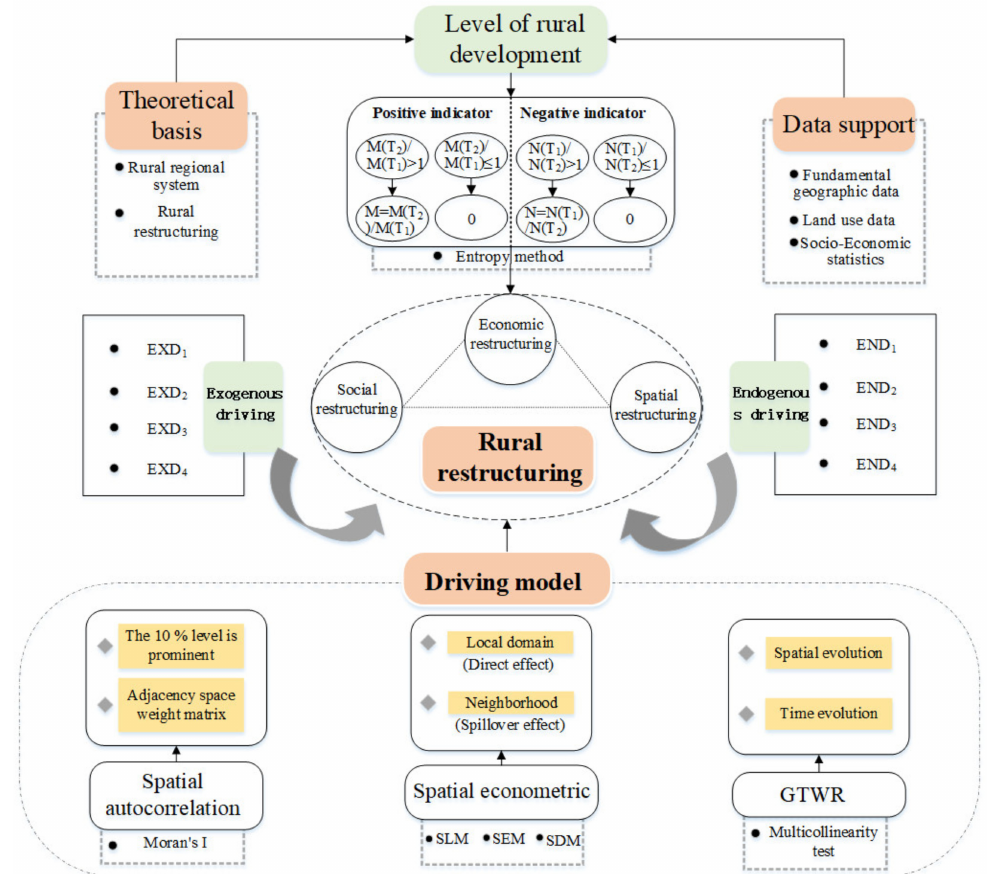
Figure 2. Research thinking